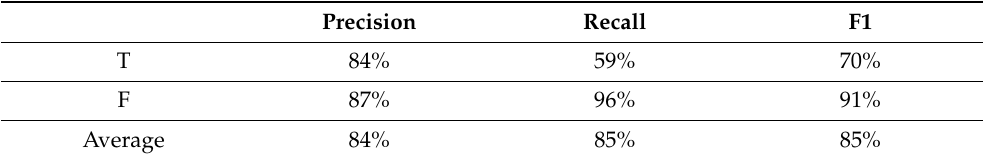
Table 5. Results from the Random Forest algorithm, using the topical and non-topical features we